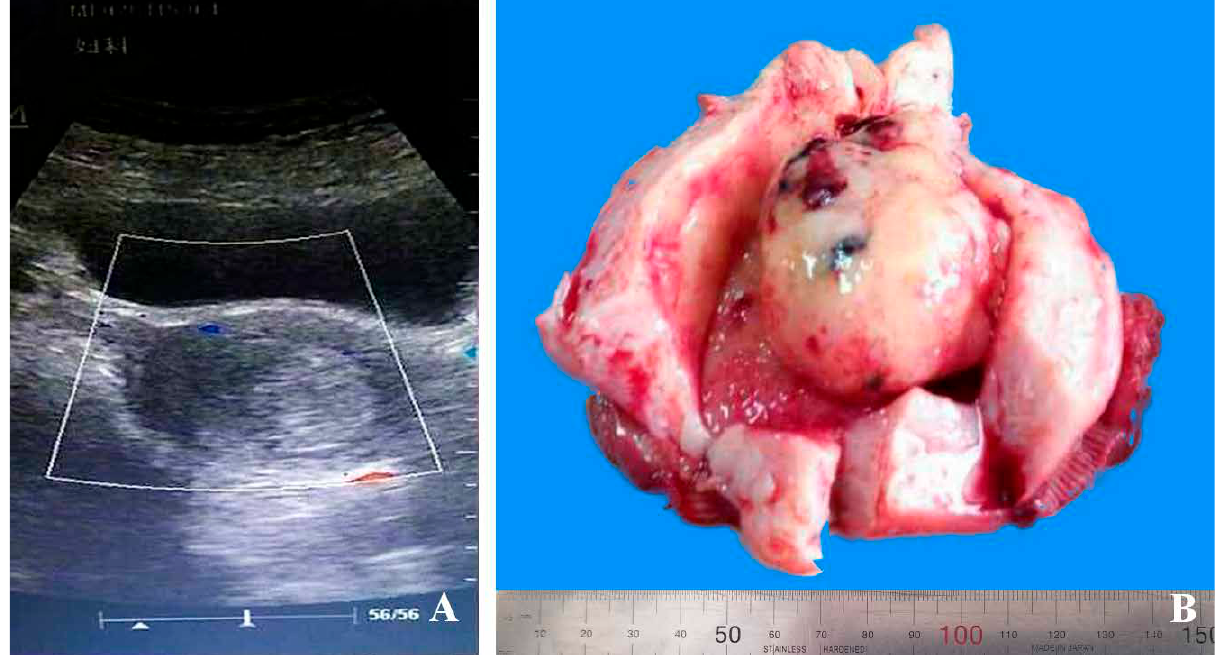
Figure 1: Imaging and gross feature of the case. A) Ultrasound images showing that the uterine cavity was occupied by an oval shaped mass. B) The gross appearance of the brown polypoid tumor located in the uterine cavity and originated from the